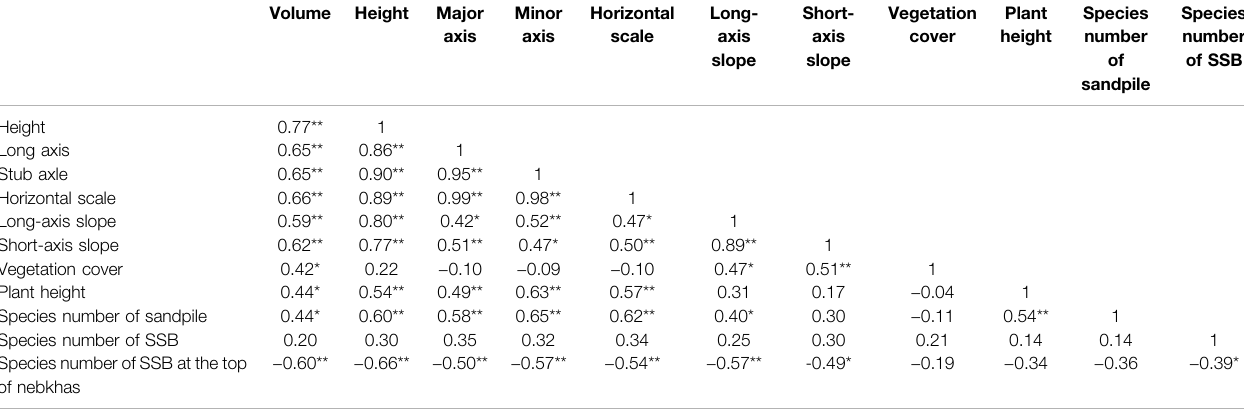
TABLE 6 | Correlation analysis of nebkha, vegetation, and soil seed bank (SSB) parameters in Nitraria tangutorum nebkhas. Volume Height Major